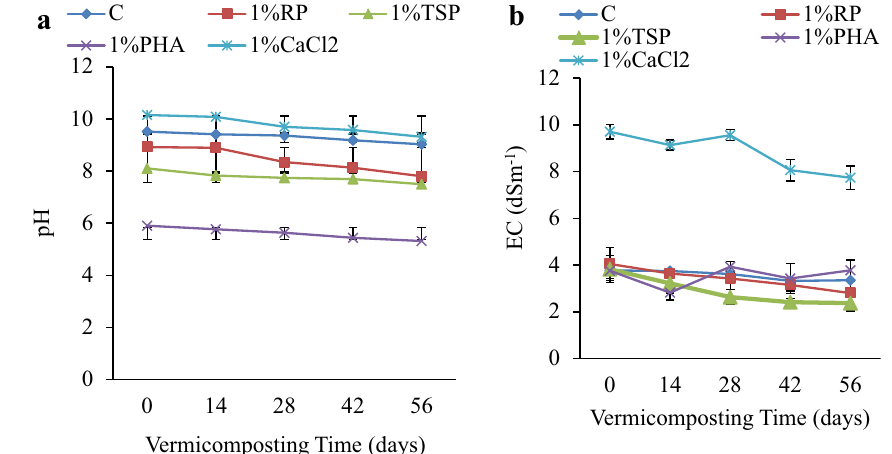
Fig. 2 Effect of P and Ca sources on pH and